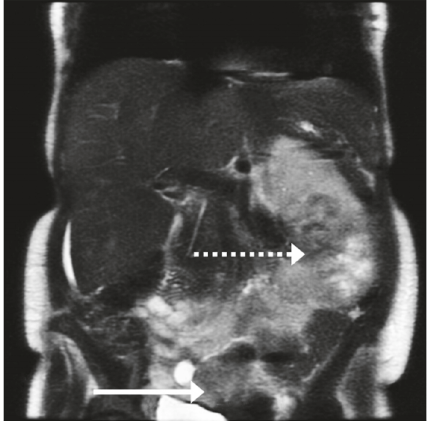
Figure 2: Axial & coronal view, CT of abdomen without contrast demonstrating multifocal left renal malignancy (dashed arrows) with metastasis to vagina as well as left hepatic lobe (solid arrows).